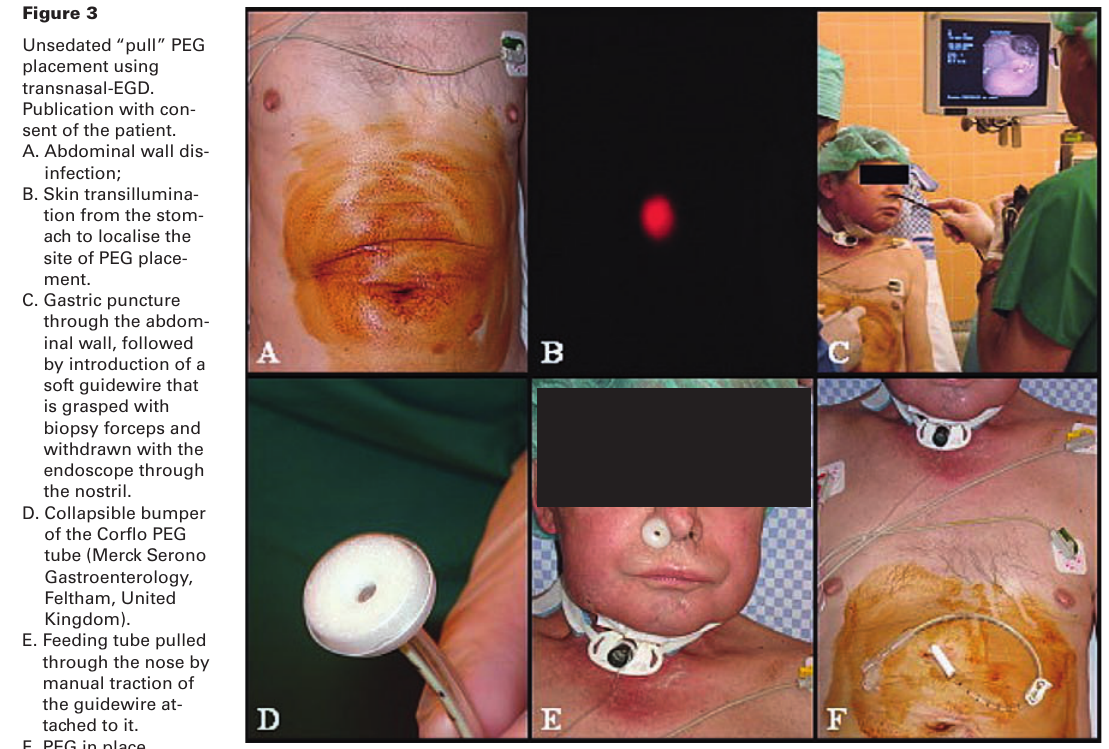
Unsedated “pull” PeG placement using transnasal-eGd. Publication with con- sent of the patient. A. Abdominal wall dis- infection; B. Skin